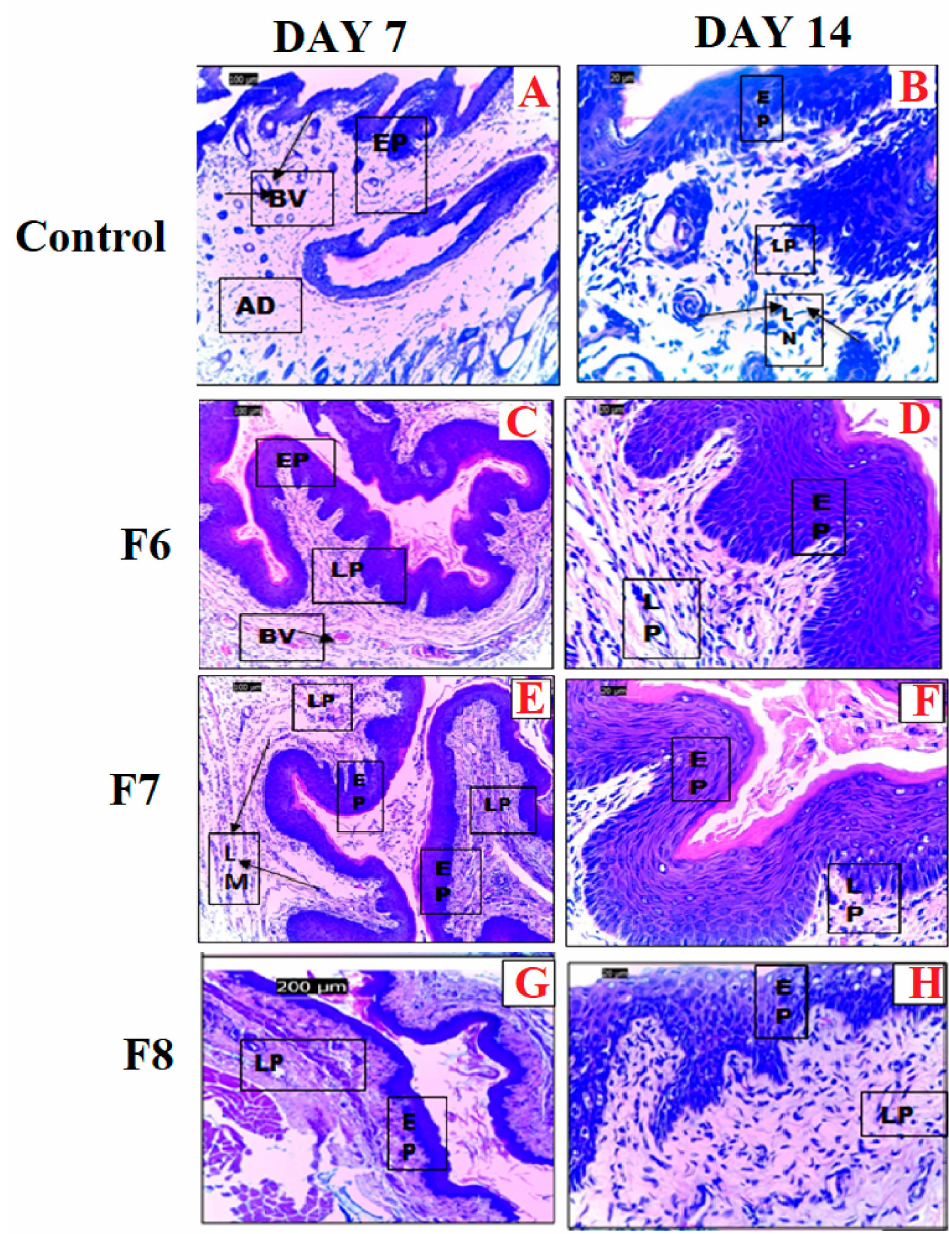
Figure 4. Photomicrographs (H & E × 100) of the histology slides of a section of the vaginal tissue treated with ( A , B ) control/no treatment, ( C , D ) electrospun scaffolds F6, ( E , F ) electrospun scaffolds F7, and ( G , H ) electrospun scaffolds F8. Lamina propria (LP), blood vessels (BVs), lymphocytes (LMs), squamous epithelium (EP), adventitia